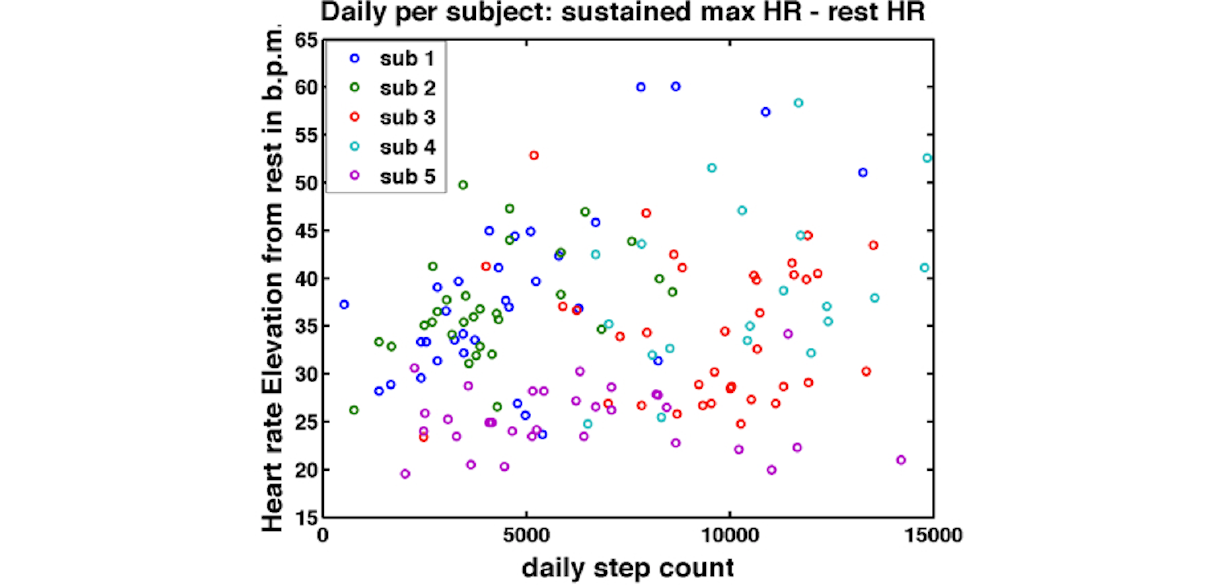
Figure 8. Sustained heart rate elevation from rest associated with daily step count, by subject. The graph plots the heart rate elevations from rest in beats per minute against each subject’s daily step